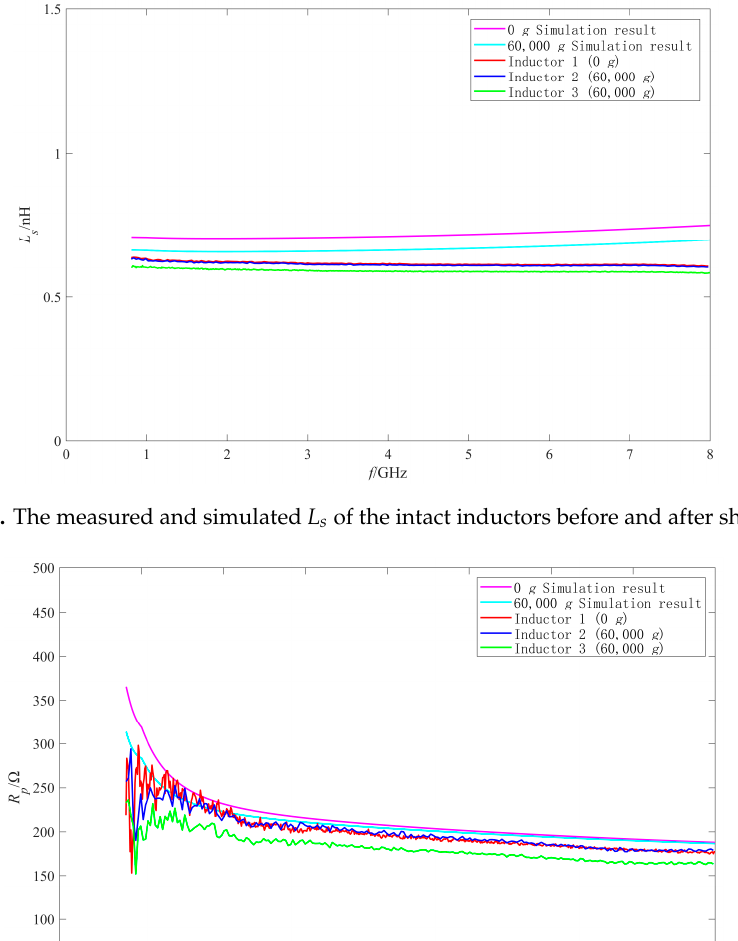
p of the intact inductors before and after shock test. Micromachines 2020 , 11 , x